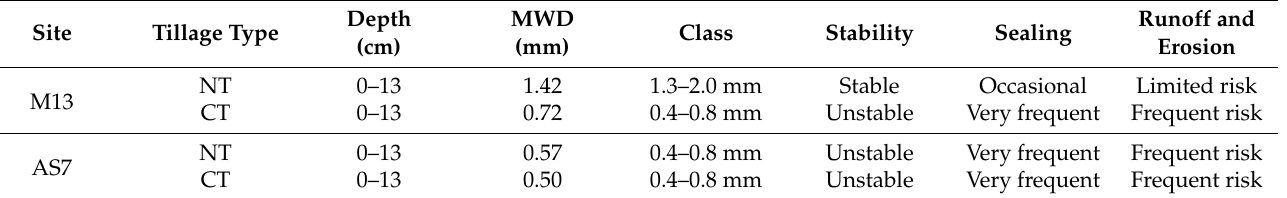
Table 5. Stability, sealing, and erosion classes are based on MWD values (average of three tests), as per the standards established by Le Bissonnais, 1995